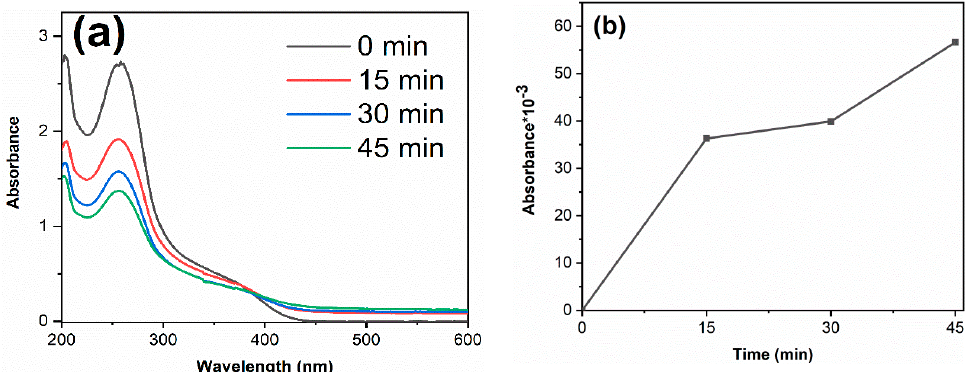
Figure 9. The absorbance curves of NBT ( a ) and 2, 3-HBA ( b ) of TiO 2 -12 h.